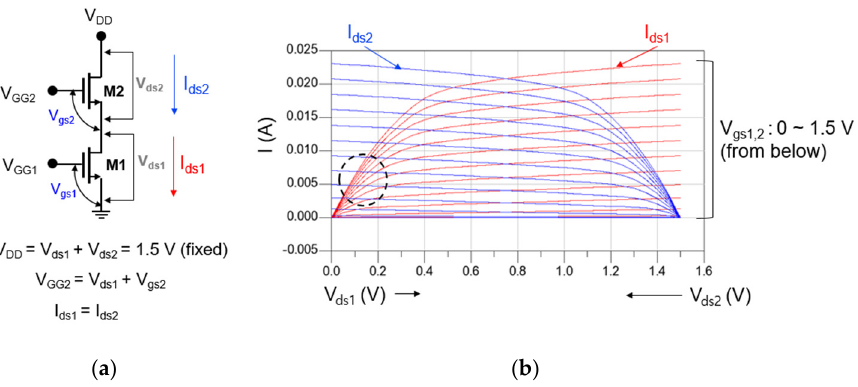
Figure 4. ( a ) Circuit schematic of the cascode mixer and ( b ) DC-IV of each transistor constituting the cascode structure.